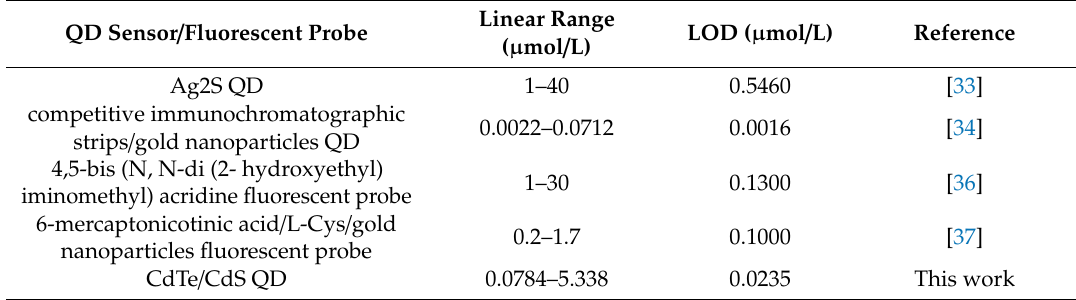
Table 1. Comparison of di ff erent QD sensors / fluorescent probes for Cd 2 +